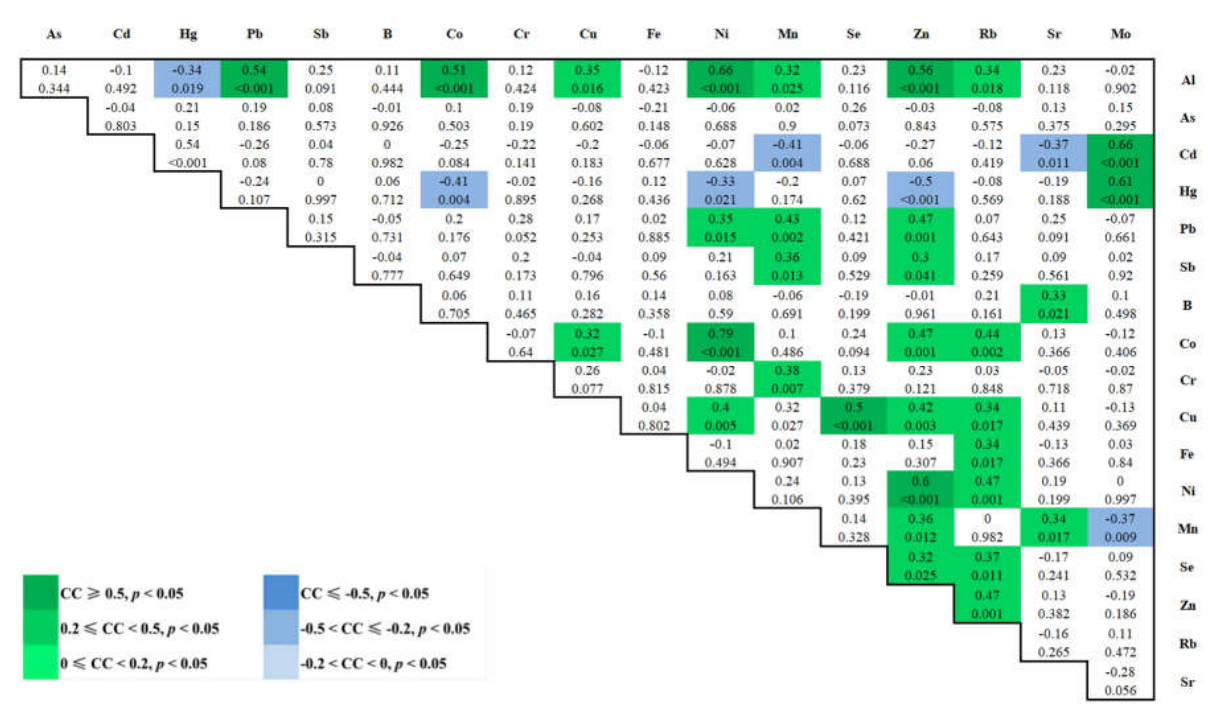
Figure 3. Color map of the Spearman correlations between 18 elements in maternal blood at 3rd trimester.